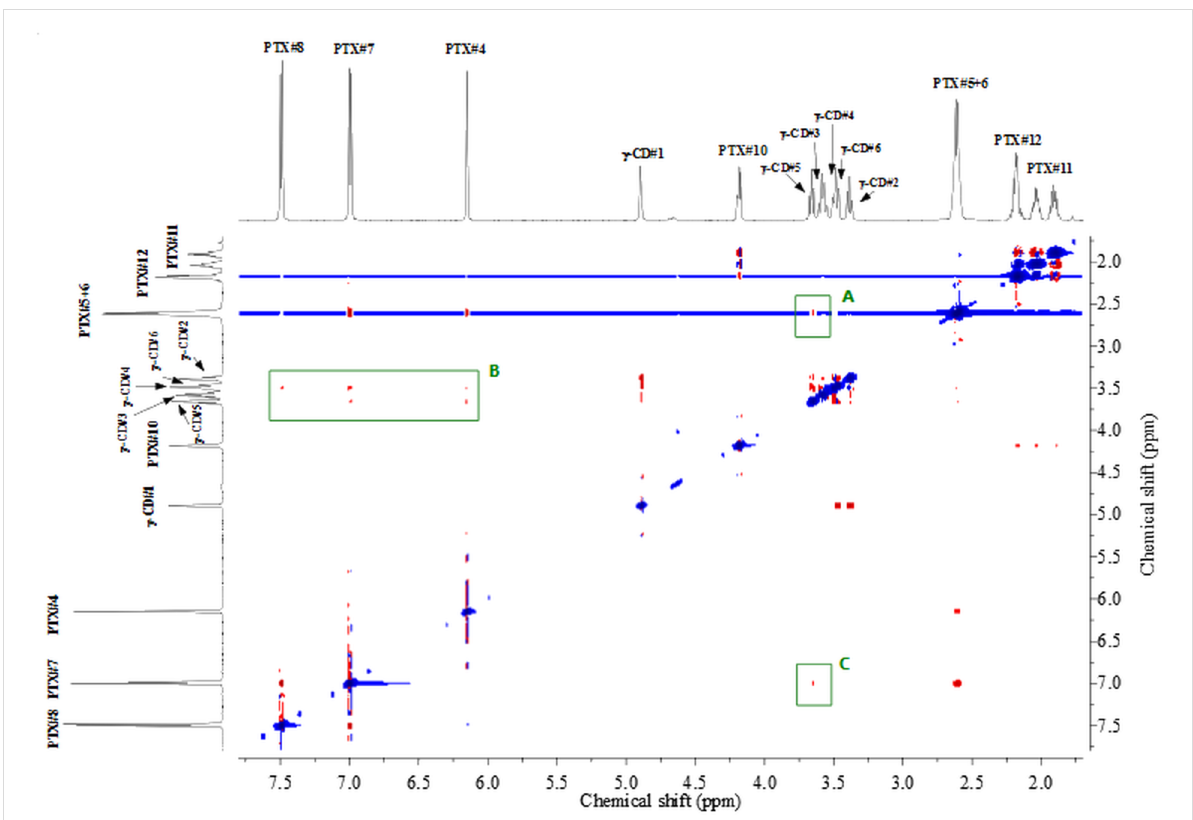
Figure 5: 2D ROESY NMR spectra of a mixture of γ -CD with a 16-fold molar excess of PTX added in D 2 O at 298